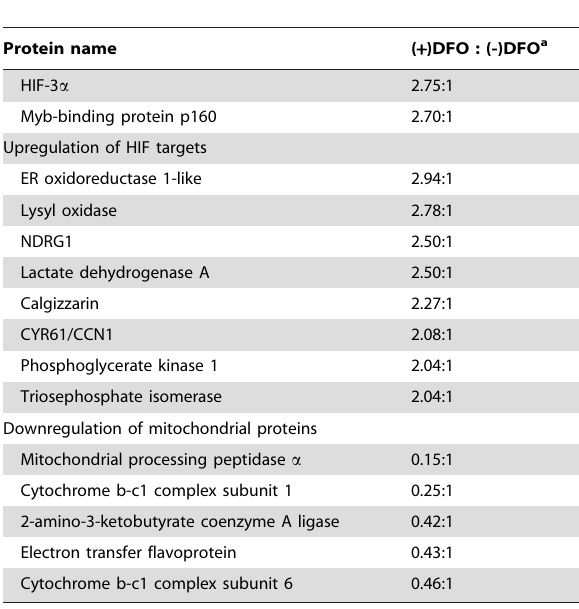
Table 1. Partial list of protein expression changes upon iron